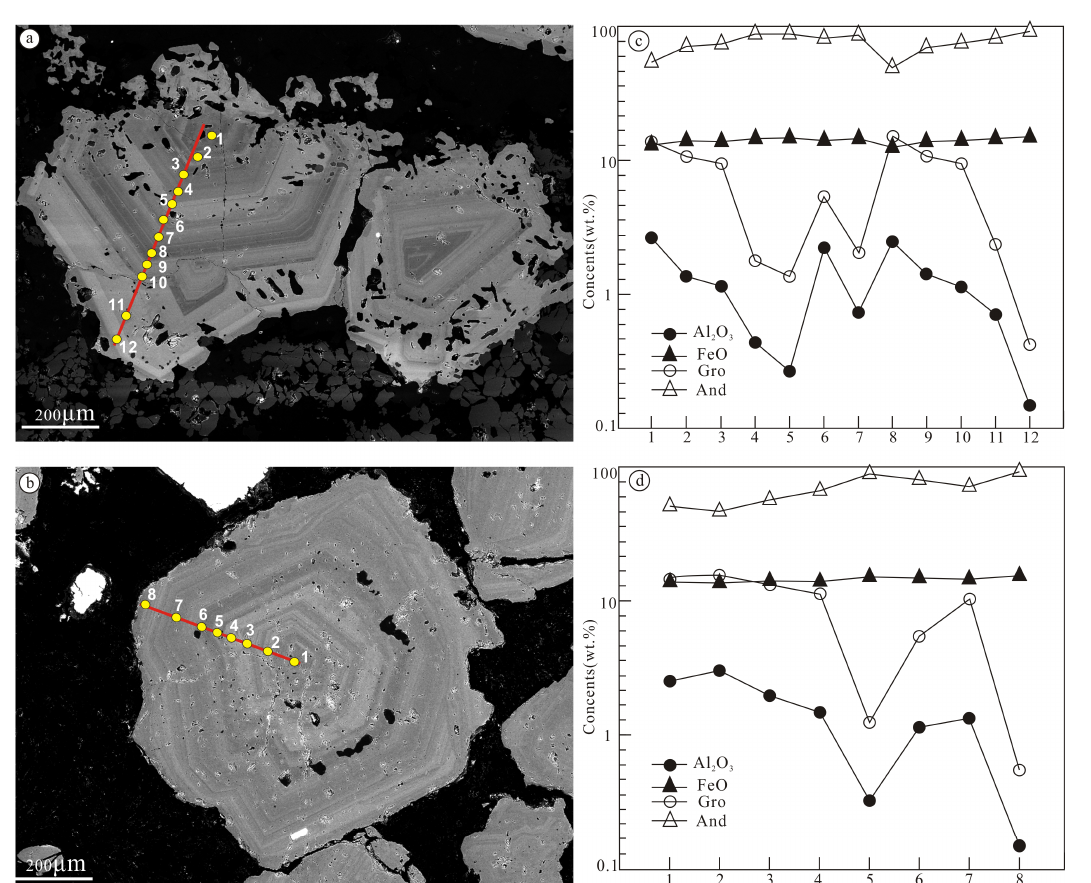
Figure 7. BSE images (left) and compositional variation profiles of the zoned garnet at Jiama deposit. Yellow dots and white numbers represent the electron probe micro analysis (EPMA) locations and spot numbers, respectively. ( a , c ) were sample ZK1213-70; ( b , d ) were sample ZK024-515. Abbreviations: And-andradite, Gro-grossular. Table 2. EPMA analysis results (wt%) and absorption peak of garnet.